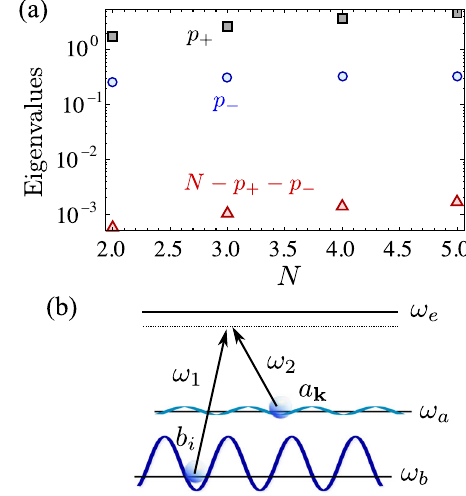
FIG. 5. (a) Eigenvalues of the correlation matrix are shown for multi-EBS as a function of N for Δ =J ¼ 0 and Ω =J ¼ 0 . 5 . (b) Scheme of the implementation with state-dependent optical lattices: two atomic states a , b are trapped in a shallow or deep i j potential and connected through a two-photon Raman